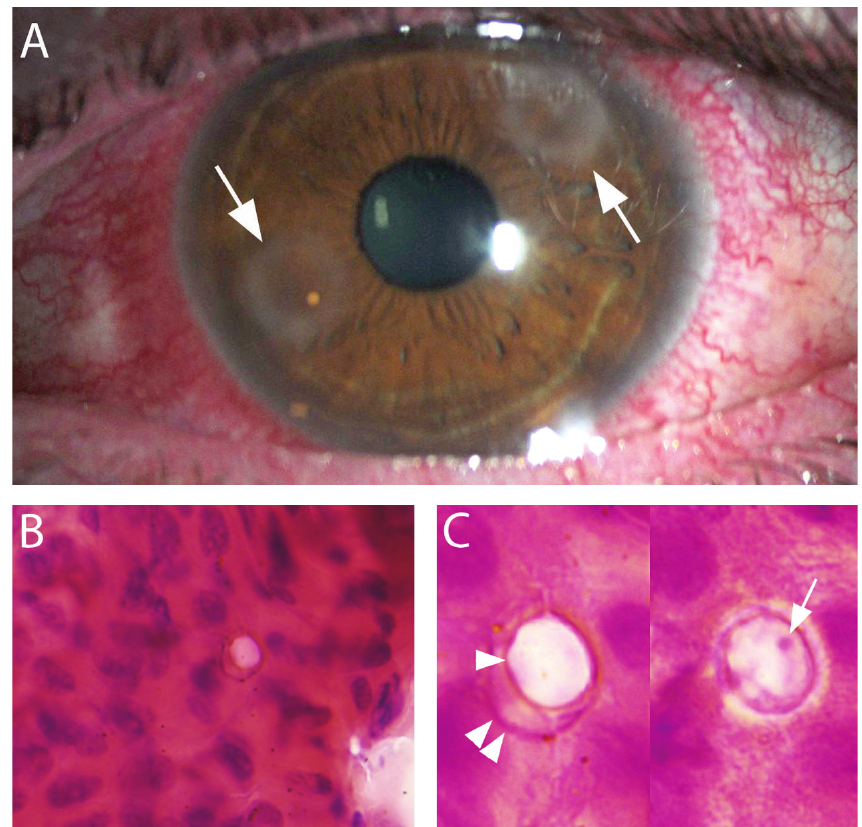
Figure 1: Acanthamoeba keratitis. (A) Photograph depicting the two peripheral corneal-ring infiltrates (arrows) in this patient. (B) Low magnification photomicrograph of H&E stained corneal epithelium scraped from the areas of infiltrates shown in panel (A). A double-walled cyst characteristic of Acanthamoeba is appreciated against the cellular background. (C) Higher magnification views of the cyst at two focal planes demonstrate the presence of the Acanthamoeba exocyst (double arrow head), endocyst (single arrowhead), and nucleolus